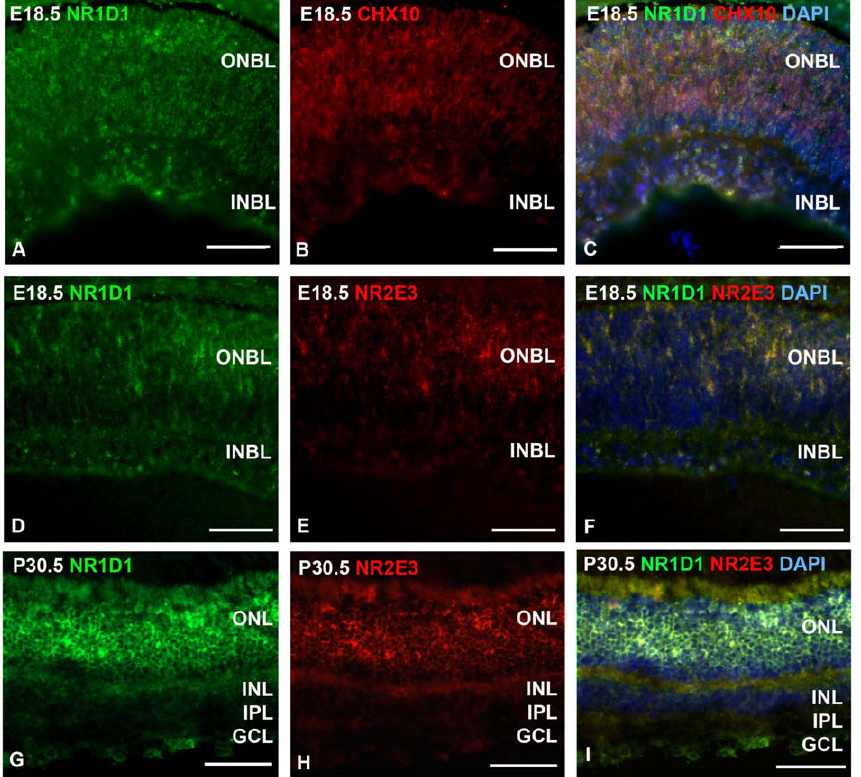
Figure 2. NR1D1 co-localizes with NR2E3 in the developing and adult retina. Immunohistochemical analysis shows NR1D1 localized to the outer neuroblastic layer (ONBL) and inner neuroblastic layer (INBL) in the embryonic day (E) 18.5 retina (A–C, D–F). A. NR1D1, B. CHX10, C. Merge + DAPI, D: NR1D1, E. NR2E3, F: Merge + DAPI. NR1D1 co-localized with progenitor cell markers CHX10 and NR2E3 (C, F). In the adult retina NR1D1 was expressed in the ONL, and GCL. G. NR1D1, H: NR2E3, I: Merge + DAPI. ONL: outer nuclear layer, OPL: outer plexiform layer, INL: inner nuclear layer, IPL: inner plexiform layer, GCL: ganglion cell layer. Scale bar =50 m m.